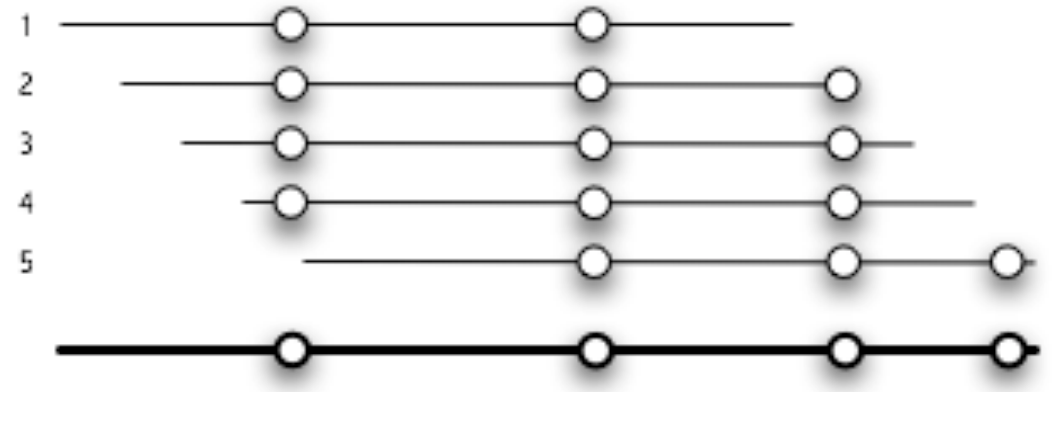
Figure 3. Fixed length patterns overlap to highlight longer regions of